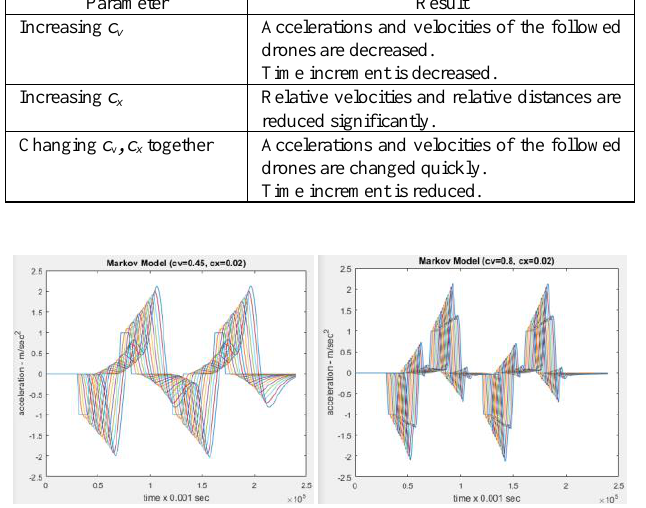
Fig. 18. The impact of the initial conditions on the acceleration.